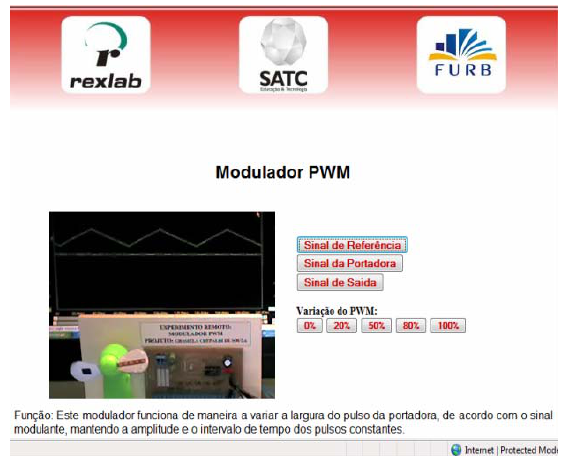
Figure 14. PWM remote experiment via internet